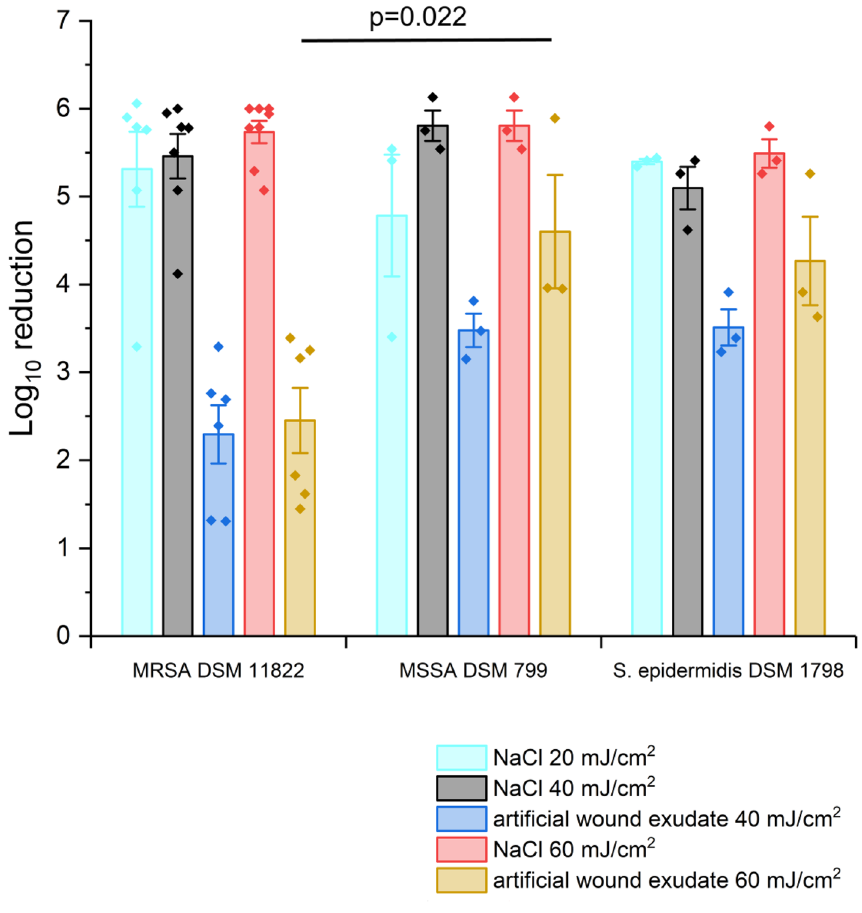
Figure 2. Log 10 reduction after treating different MRSA DSM 1182 and MSSA DSM 799 strains as well as S. epidermidis DSM 1798 with doses of 40 mJ/cm 2 and 60 mJ/cm 2 at 233 nm. Microorganisms were suspended in sodium chloride solution (20 mJ/cm 2 , cyan; 40 mJ/cm 2 , black; 60 mJ/cm 2 , red) or artificial wound exudate (40 mJ/cm 2 , blue; 60 mJ/cm 2 , orange) before drying on germ carriers for 30 min following irradiation. Multiple mean value comparisons were conducted to check for differences between the strains. The presented p-value is based on a Kruskal–Wallis test followed by pairwise post hoc tests with Bonferroni correction. The data show mean ± SEM. n =